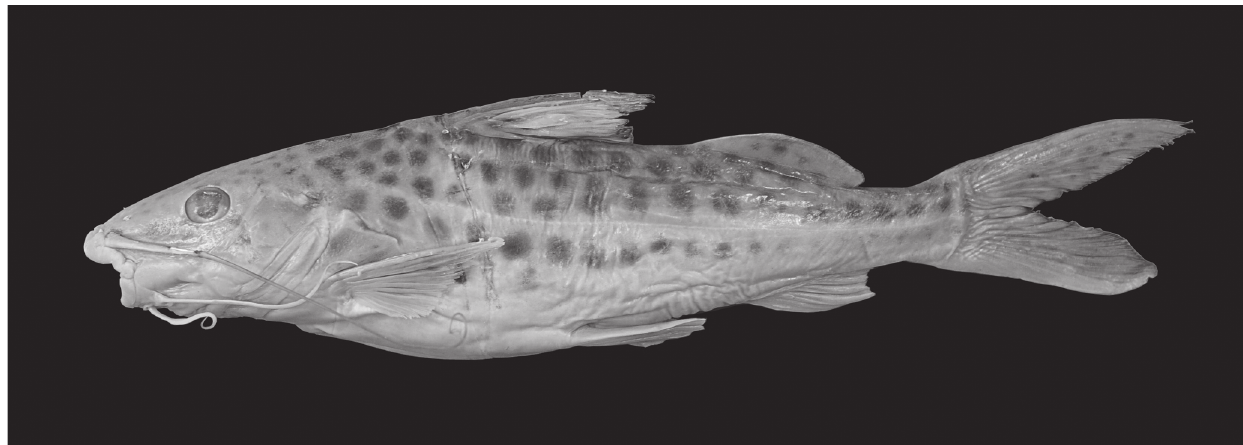
Fig. 2. Pimelodus multicratifer , paratype, MZUSP 45465, 118.6 mm SL, rio Pilões, rio Ribeira de Iguape basin, lateral